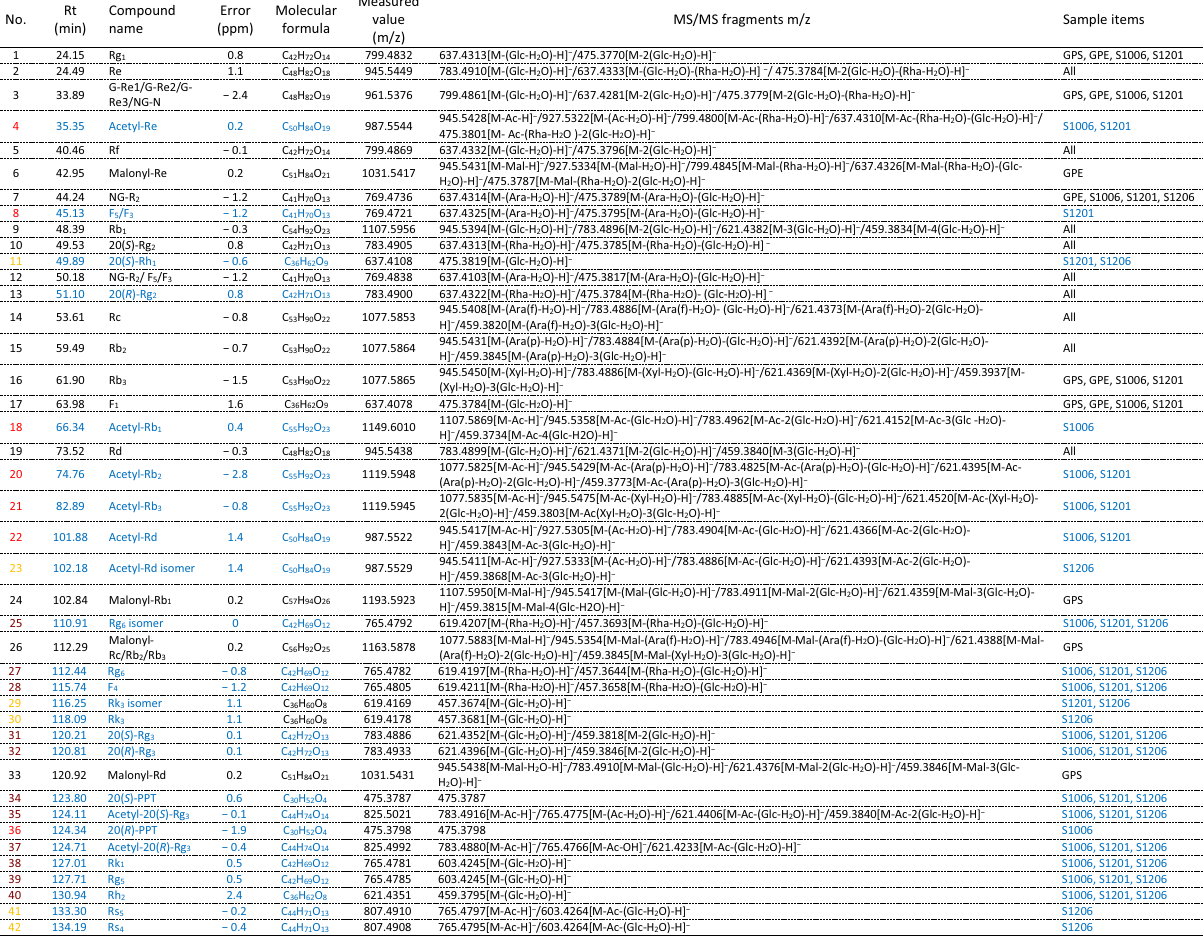
and/or C-20 (protopanaxadiols) or at C-6 and/or C-20 (protopanaxatriols) from their corresponding proto-